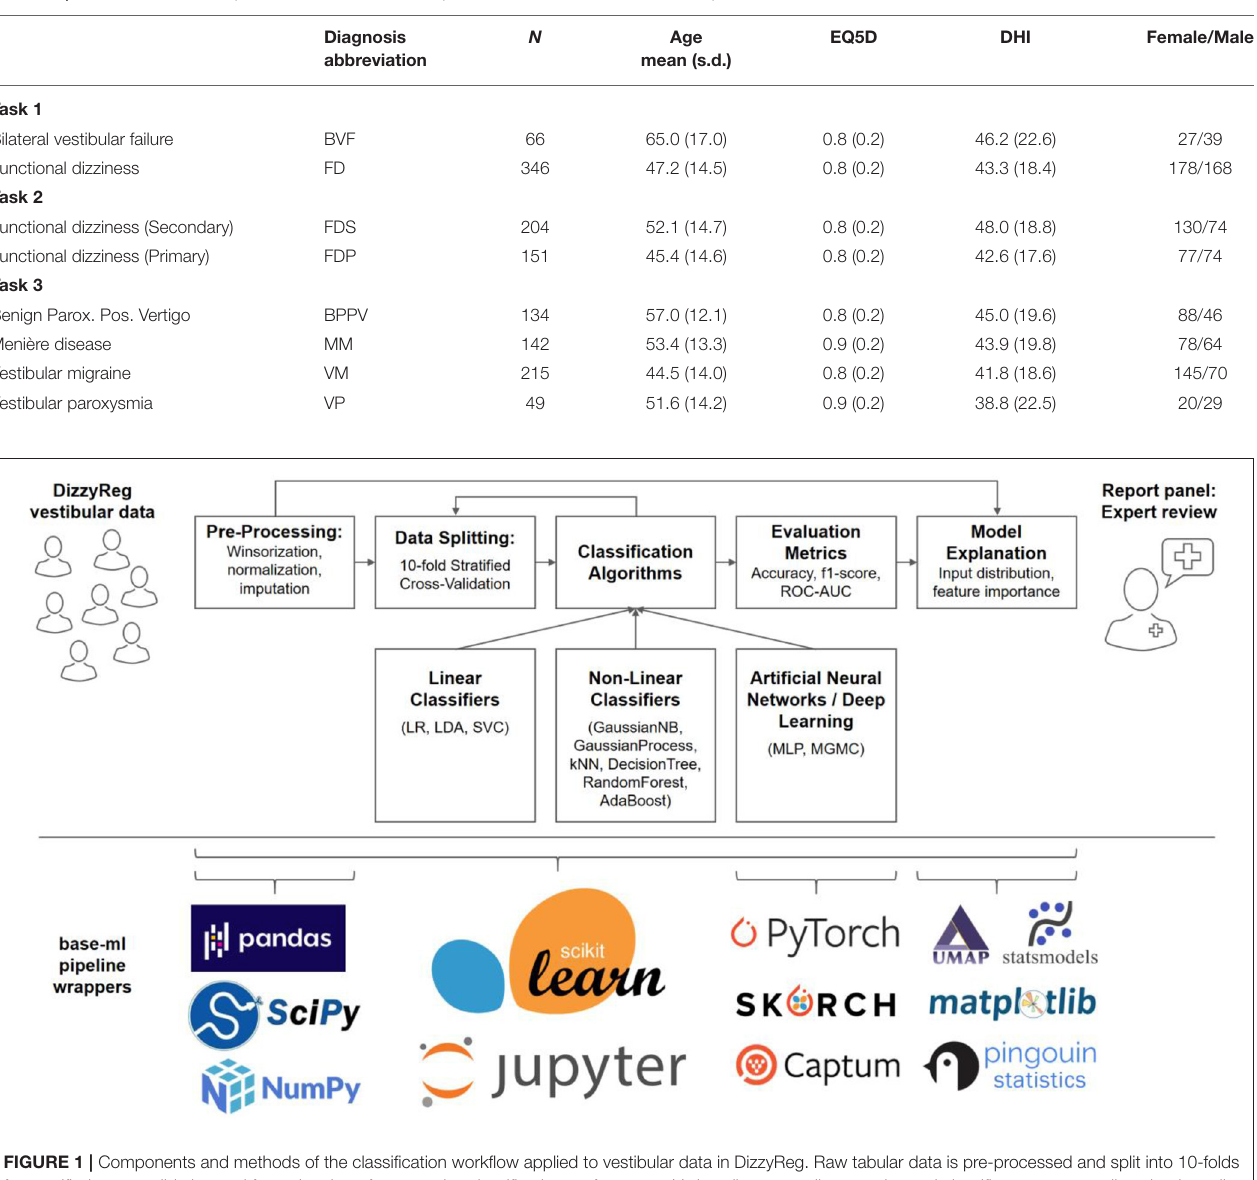
TABLE 1 | Clinical tasks with respective classes of chronic/episodic vestibular disorders, and respective cohort details.